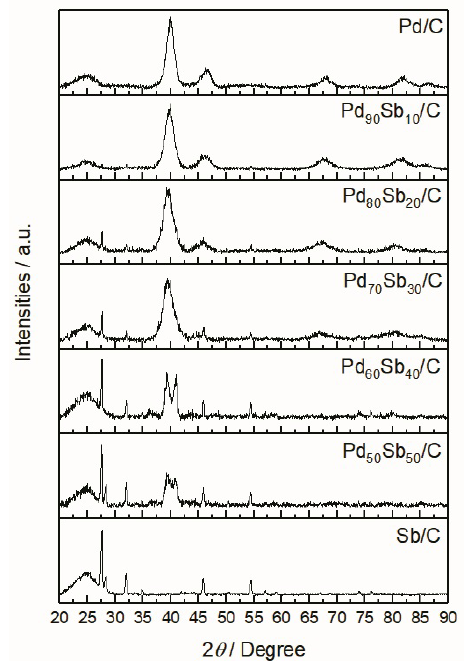
Figure 1. X-ray diffractograms of PdSb/C catalysts and different